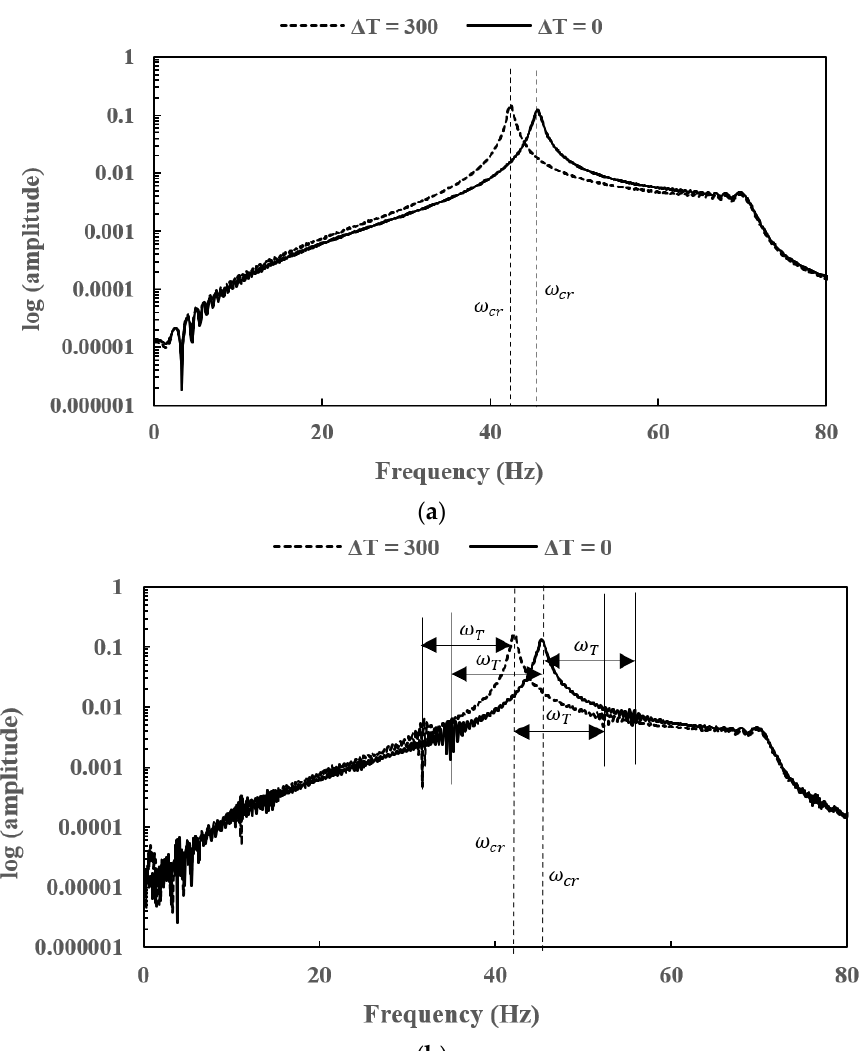
Figure 17. Transient FFT of ( a ) uncracked ( b ) slant − cracked EG rotor-bearing system with an angular acceleration of 30 rad/s 2 , torsional frequency ( ω T ) = 65 rad/s and, α = 0.3 at ∆ T = 0 and ∆ T = 300